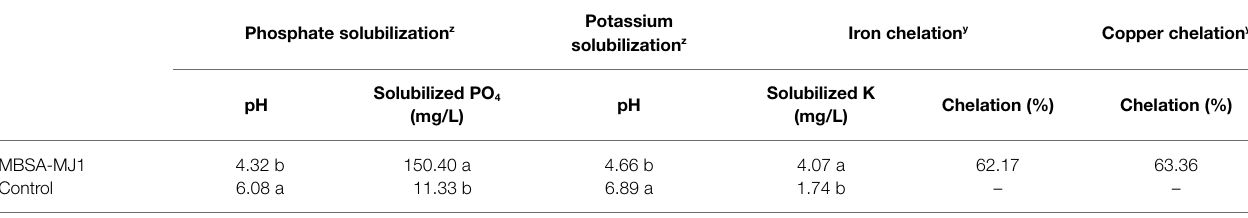
TABLE 1 | In vitro characterization of nutrient solubilization and chelation abilities of S. plymuthica MBSA-MJ1.